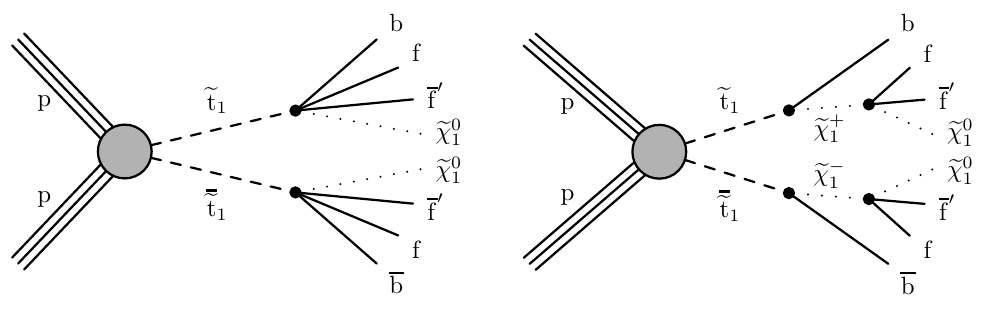
Figure 1 . Top squark pair production at the LHC with four-body (left) or chargino-mediated (right)